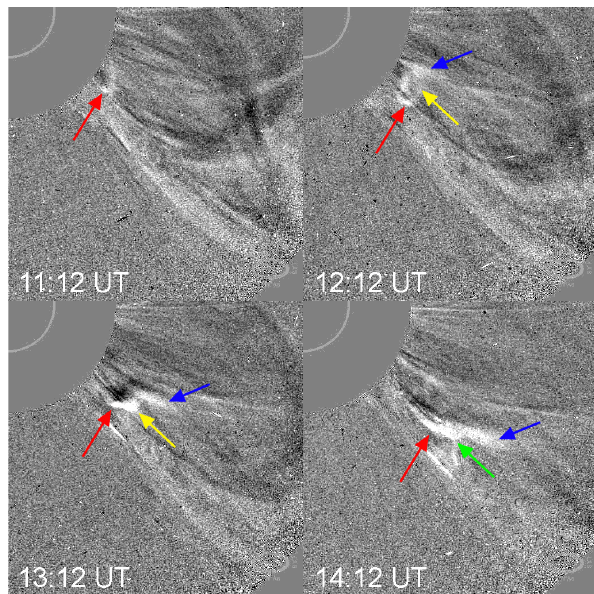
Fig. 3. LASCO/C2 difference images showing the white light evo- lution during the secondary eruption. From these images we es- timated the outflow speeds of different features (tentatively iden- tified with arrows of different colors) that turn out to be between ∼ 40km/s (red arrowed feature) and ∼ 250km/s (blue arrowed fea-